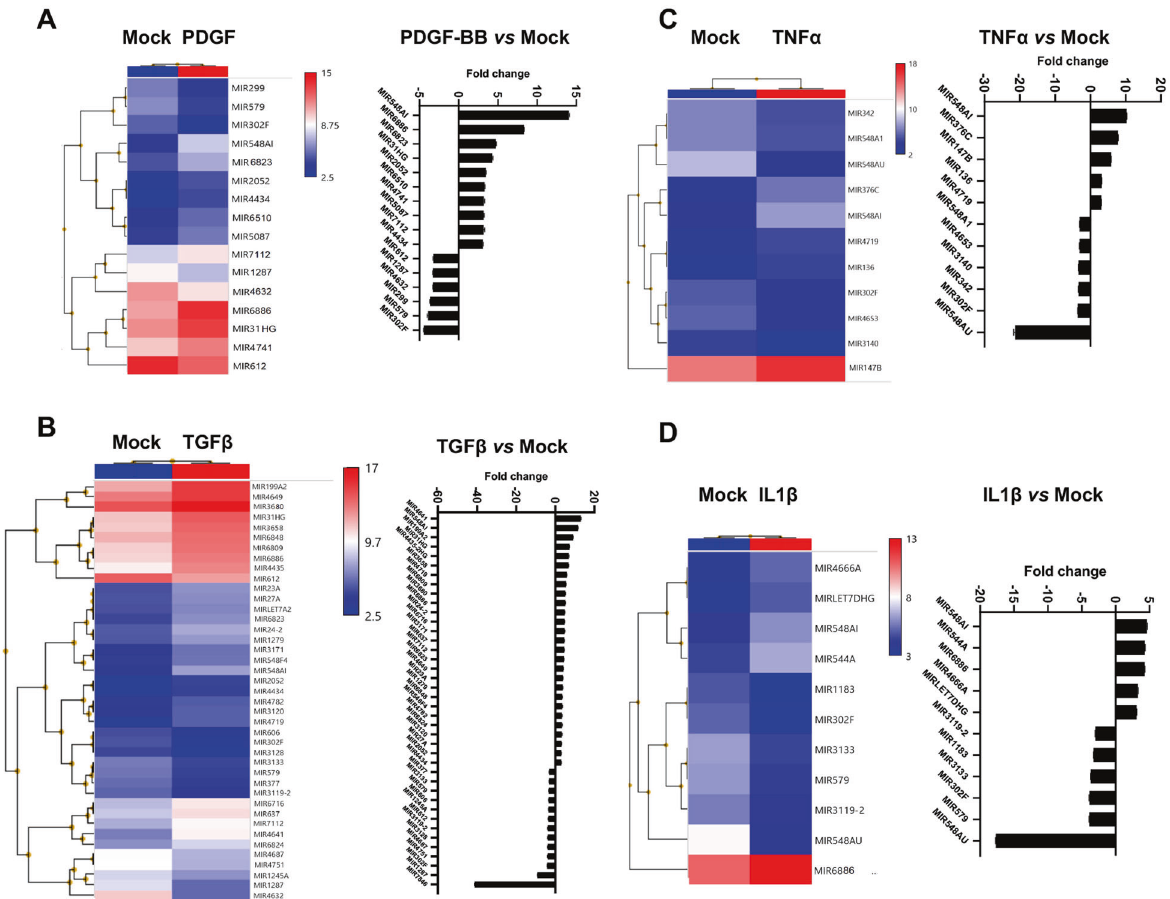
Fig. 2 Pro fi les of SMC-derived, up- or down-regulated microRNAs after cytokine stimulation. Starved AoSMCs were cultured for 48 h without (Mock control) or with a cytokine ( A : PDGF-BB, B : TGF β 1, C : TNF α , D : IL1 β ). Total RNA extracted from AoSMCs was used for microarray and microRNA pro fi ling. Shown are heatmaps and fold-change pro fi les of microRNAs that meet the criterion of log2-fold change >2 (cytokine vs. Mock).